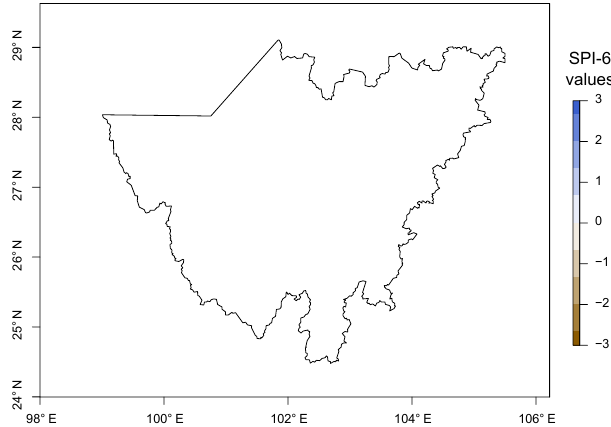
Figure 3. Extrapolated SPI-6 values in October 2012 for the entire lower